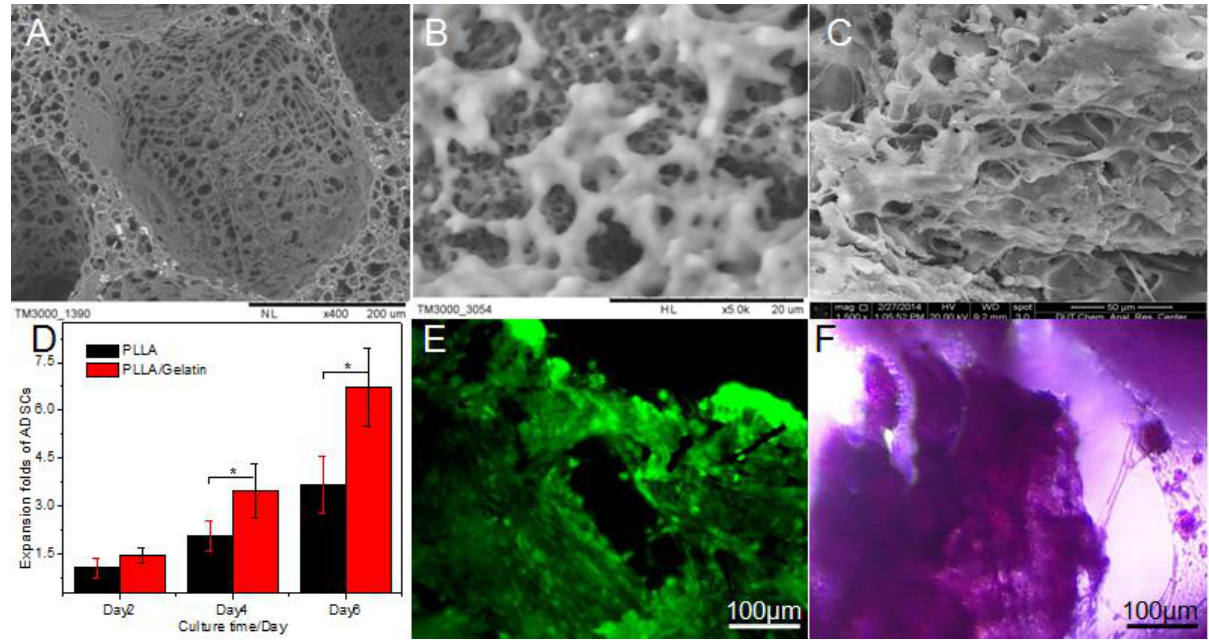
Figure 4. SEM photograph, expansion folds of ADSCs in different scaffolds, representative images for dead/live assay of ADSCs on PLLA/gelatin scaffolds and mineralized tissue formation determined by staining with alizarin red s after 7 days of fabrication. ( A ) Typical morphology of one large pore of PLLA/gelatin scaffold; ( B ) Micro holes of PLLA/gelatin scaffold; ( C ) ADSCs adhered to the surface of PLLA/gelatin scaffold; ( D ) Expansion folds of ADSCs in different scaffolds; ( E ) Fluorescence images for dead/live assay of cell/scaffold constructs; ( F ) Mineralized tissue formation determined by staining with Alizarin Red S. E , F :